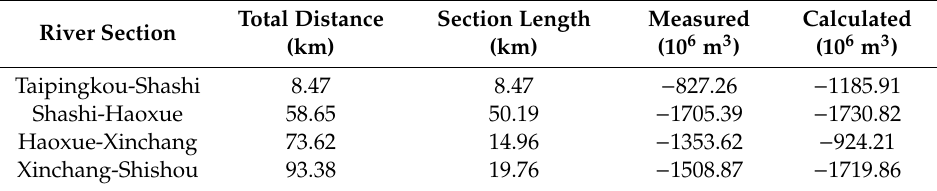
Table 3. Measured and calculated volumes of deposition ( + ) or scour ( − ). River section